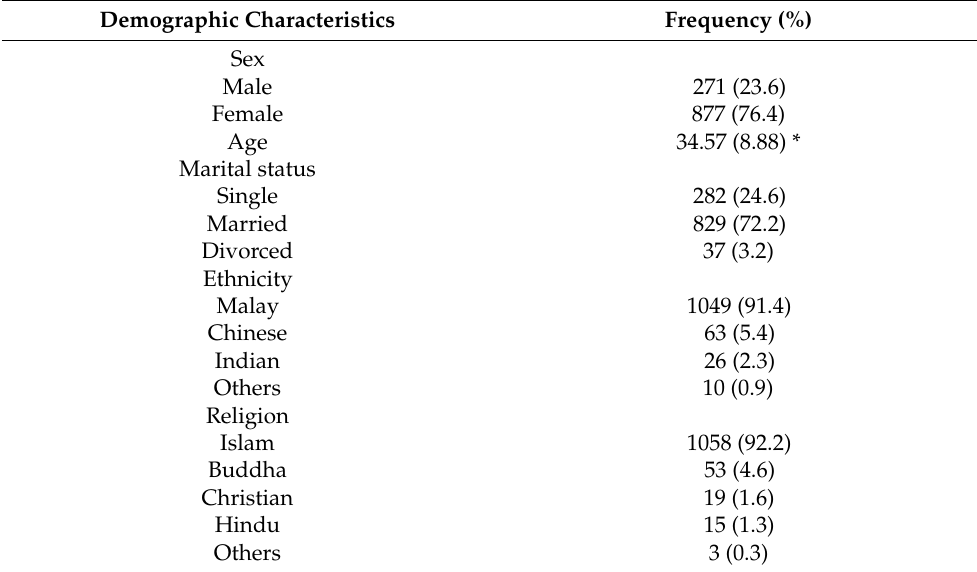
Table 1. Characteristics of participants ( n =